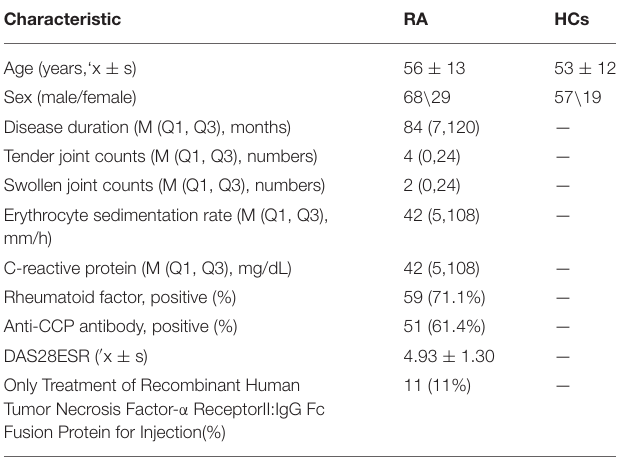
TABLE 1 | Clinical and demographic characteristics of patients and healthy controls.